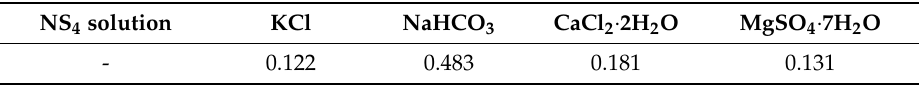
Table 3. NS 4 solution composition (g / L)